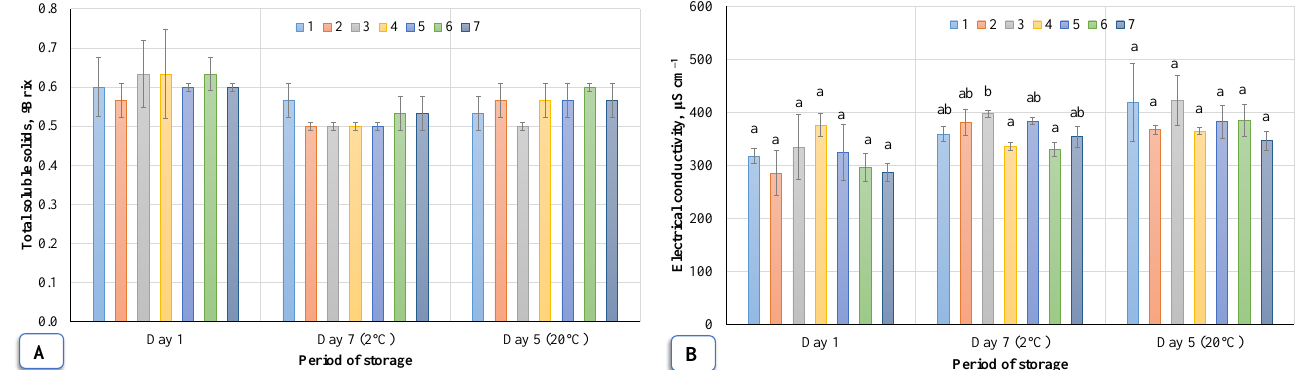
Figure 9. Variation of total soluble solids ( A ) and electric conductivity ( B ) of birch sap during storage: 1 (control) — not ozonated sap (initial); 2 — sap ozonated for 5 min; 3 — sap ozonated for 10 min; 4 — sap ozonated for 15 min; 5 — sap ozonated for 20 min; 6 — sap ozonated for 25 min; 7 — sap ozonated for 30 min. Significant differences ( p < 0.05) were found according to a Tukey HSD test (marked in lower case) ( n = 6).